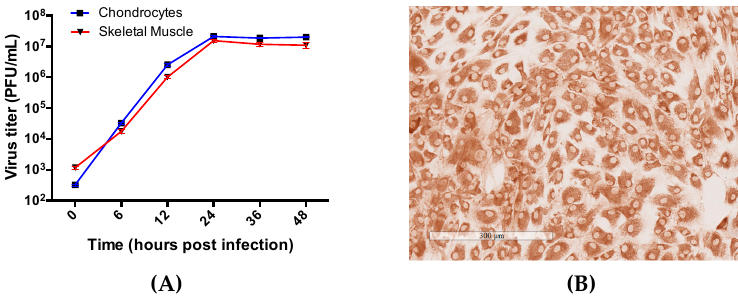
Figure 2. Human chondrocyte cells are susceptible to Ross River virus (RRV) infection. ( A ) In vitro virus titers (PFU/mL) of RRV-infected human chondrocyte cells (blue) and human skeletal muscle (red) cells at time-points 0, 6, 12, 36, and 48 h post-infection (h.p.i.) with data represented as means of triplicate samples with SEM. ( B ) Characterisation of type II collagen expression in human chondrocyte cells (brown). Image taken at 10× magnification.